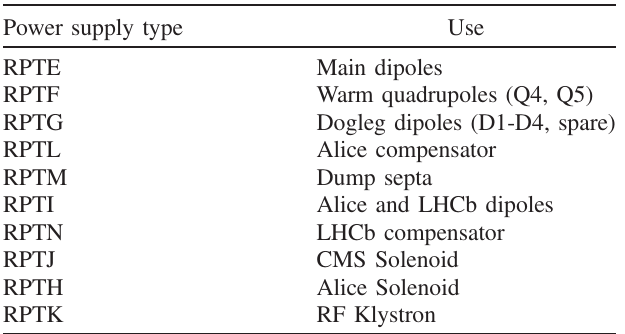
TABLE I. The SCR power supplies in the LHC [41,42].